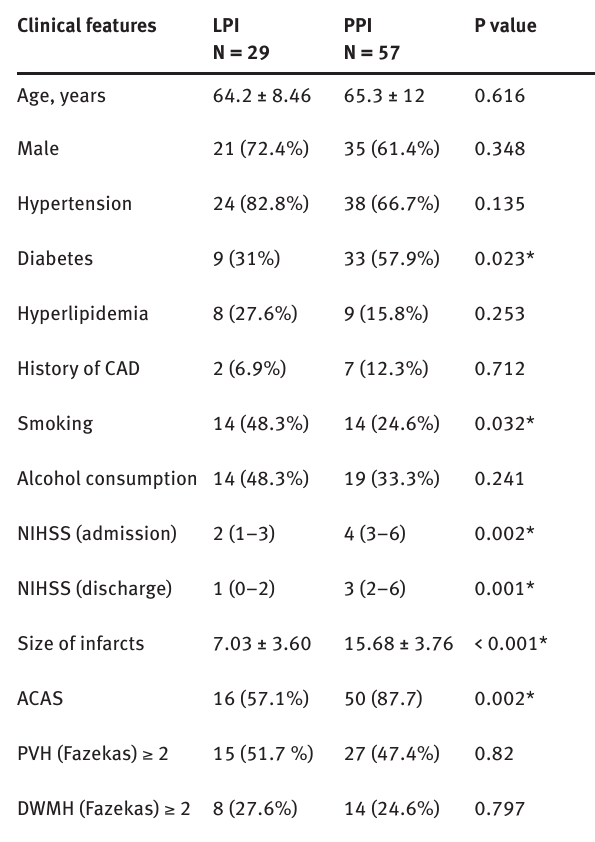
Table 1: Characteristics due to the presence of parent artery disease (PAD)